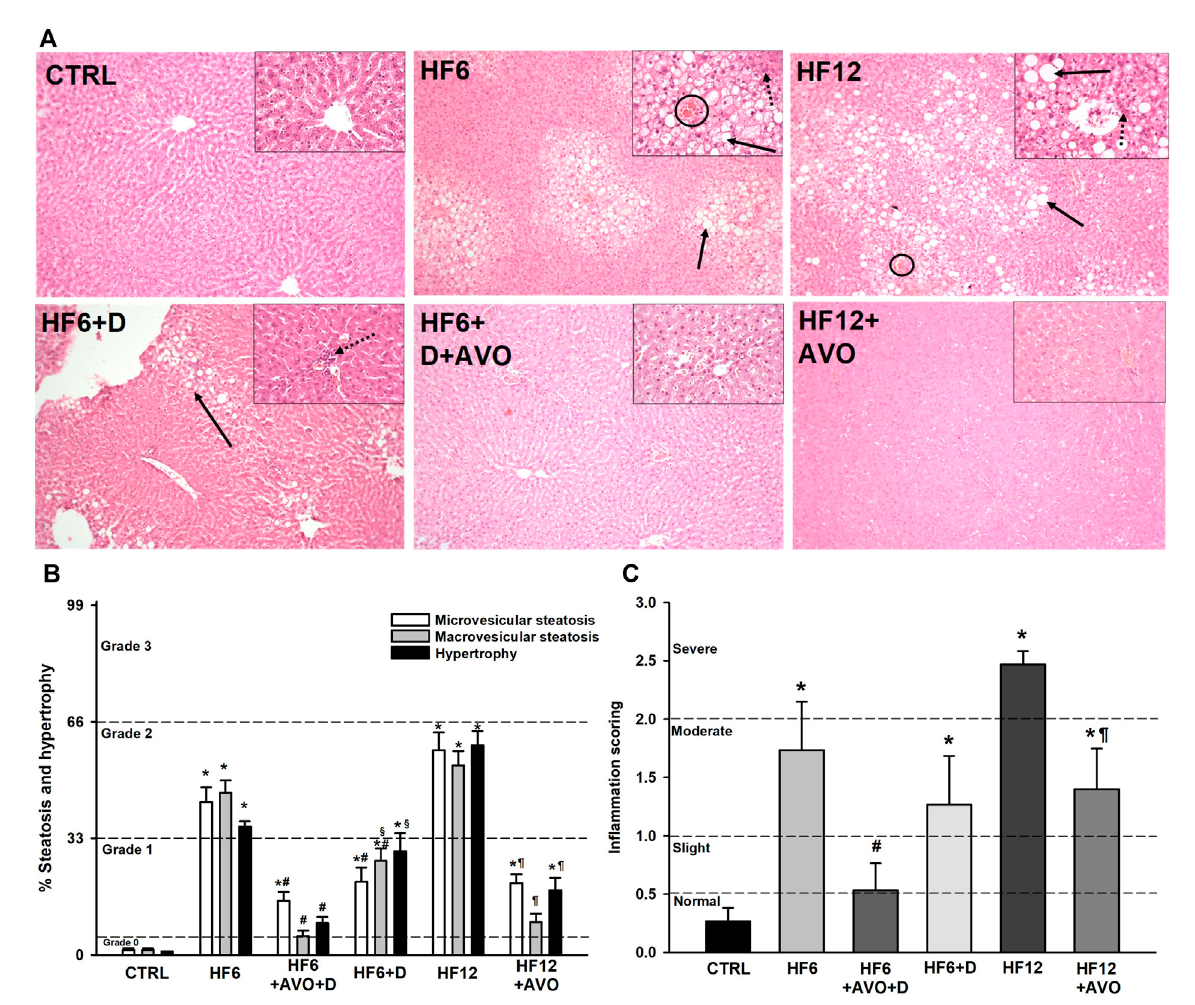
FIGURE 3 Effects of avocado oil on NAFLD development. The images are representative of four independent hematoxylin and eosin histological examinationsofliversdissected fromdifferentanimals.Blackarrowsindicate thepresence ofsteatosis;dotted blackarrows indicatethepresenceof in fl ammatoryin fi ltrates;circlesindicatethepresenceofMallory ’ shyaline.Theimagesweretakenat×10magni fi cation,whiletheimagesintheinserts were taken at ×20 magni fi cation (A) . Scoring of the percentage of steatosis and hypertrophy. The dotted lines delimit the percentage of steatosis or hypertrophy corresponding to different categories according to Liang et al. (2014): 0 ( < 5%), 1 (5% – 33%), 2 (34% – 66%) and 3 ( > 66%) (B) . Scoring of in fl ammation: normal ( < 0.5), slight (0.5 – 1.0), moderate (1.0 – 2.0), severe ( > 2.0). These categories are delimited by dotted lines (C) , according to the criteria by Liang et al. (2014). Data are expressed as the mean ± standard error of n = 3. * p < 0.05 vs. CTRL; # p < 0.05 vs. HF6; § p < 0.05 vs. HF6+AVO + D; ¶ p < 0.05 vs. HF12 (ANOVA, Holm- Š ídák ’ s post hoc